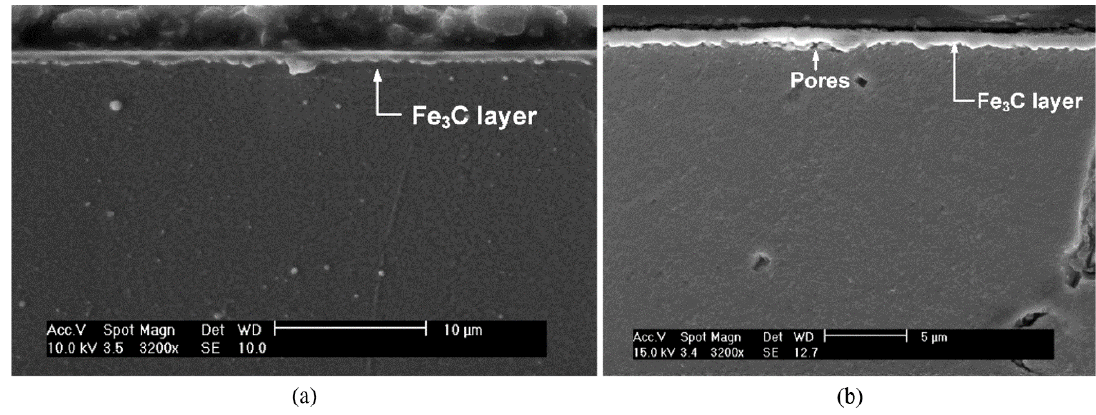
Figure 5. Cross-sectional micrographs of samples carburized at 500 °C with 5% CH